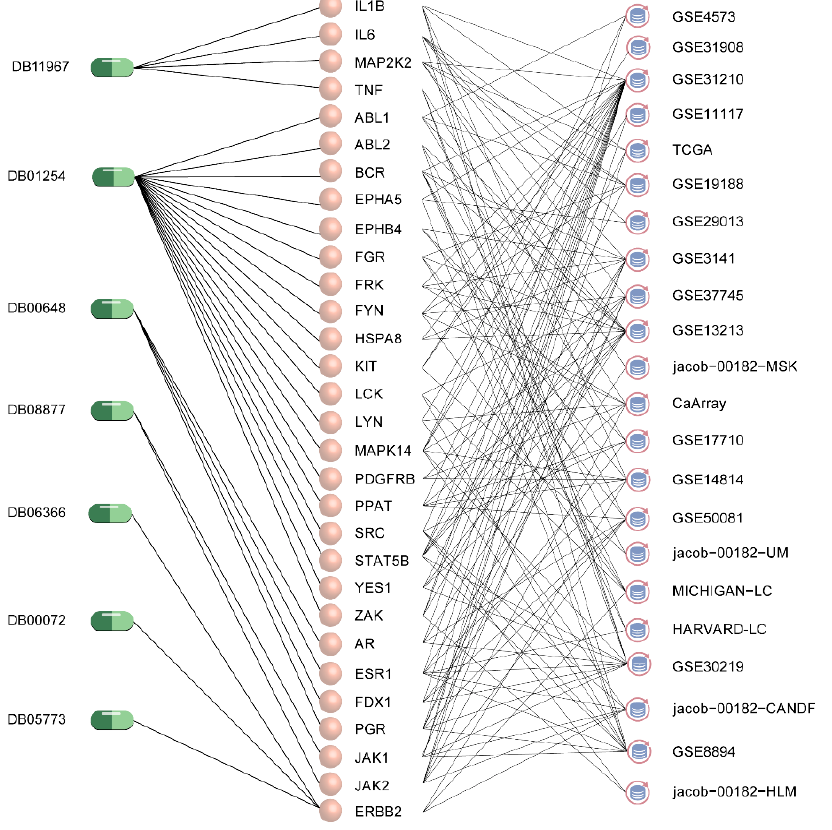
Figure 5. Survival analysis of potential repurposed drugs.